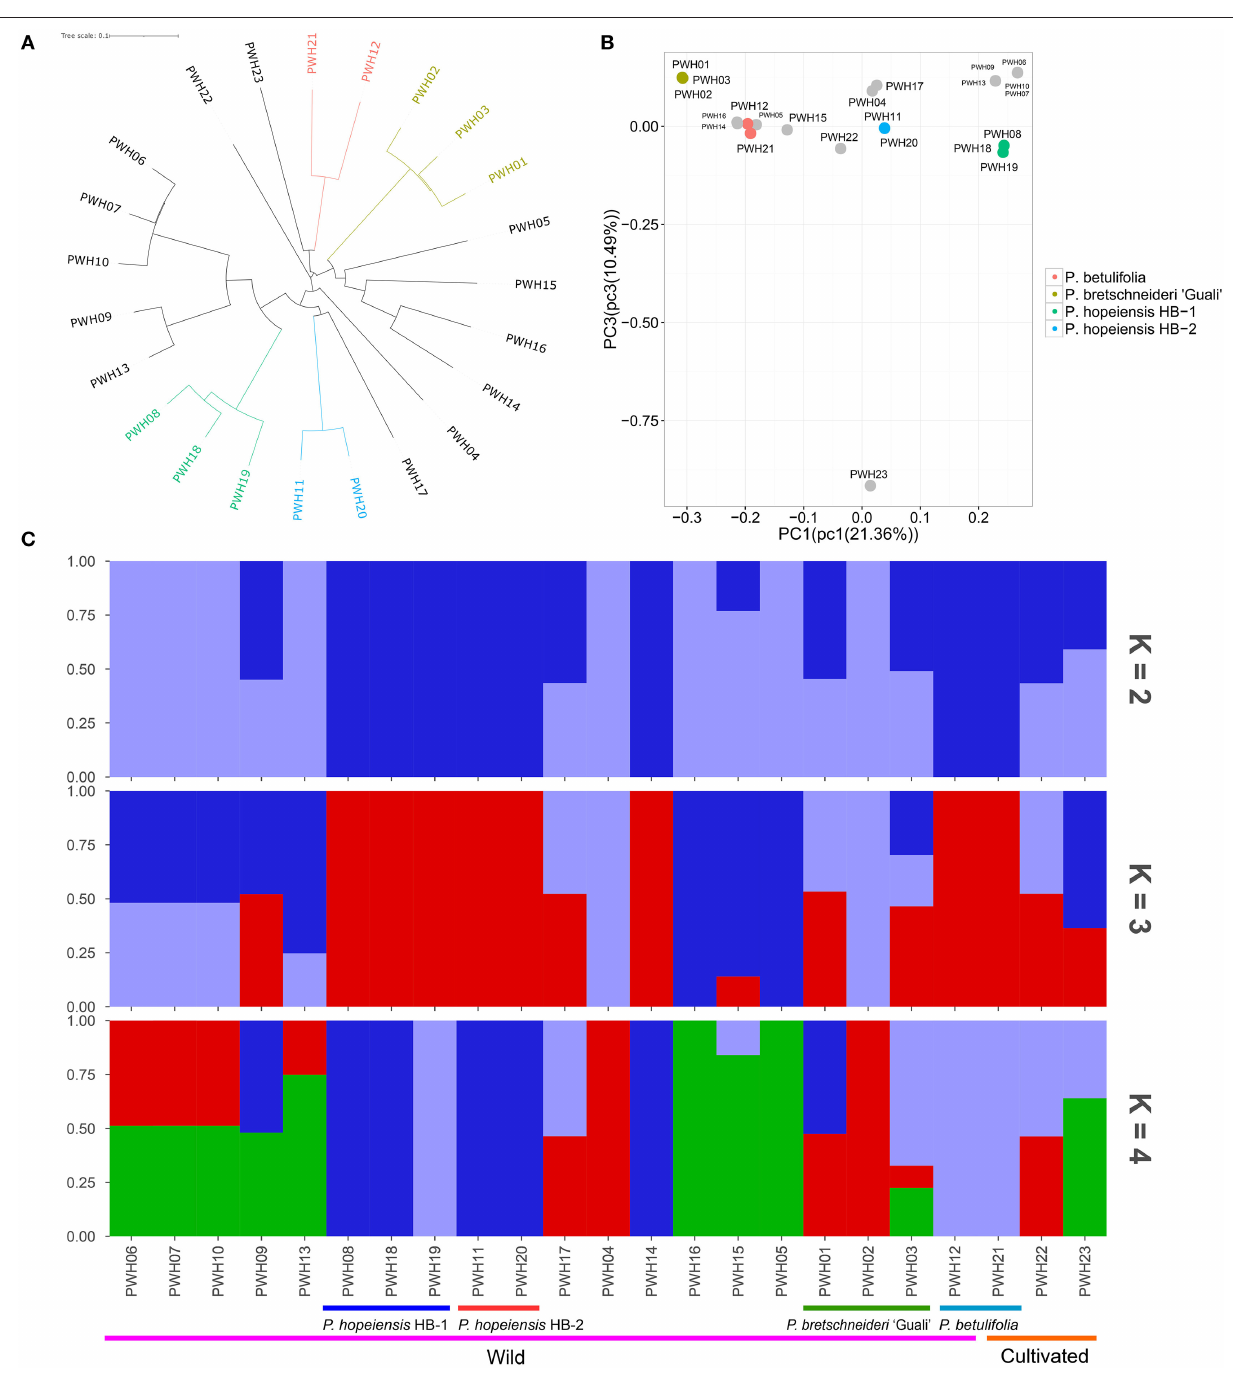
values (Fst > 0.45) and regions with elevated π ratios ( π ratio > 1.07) were selected. A total of 381 overlapping genes including SAUR72 , IAA20 , HSFA2 , and RKP genes with strong selection signals ( Figure 8C ) ( Supplementary Table 7